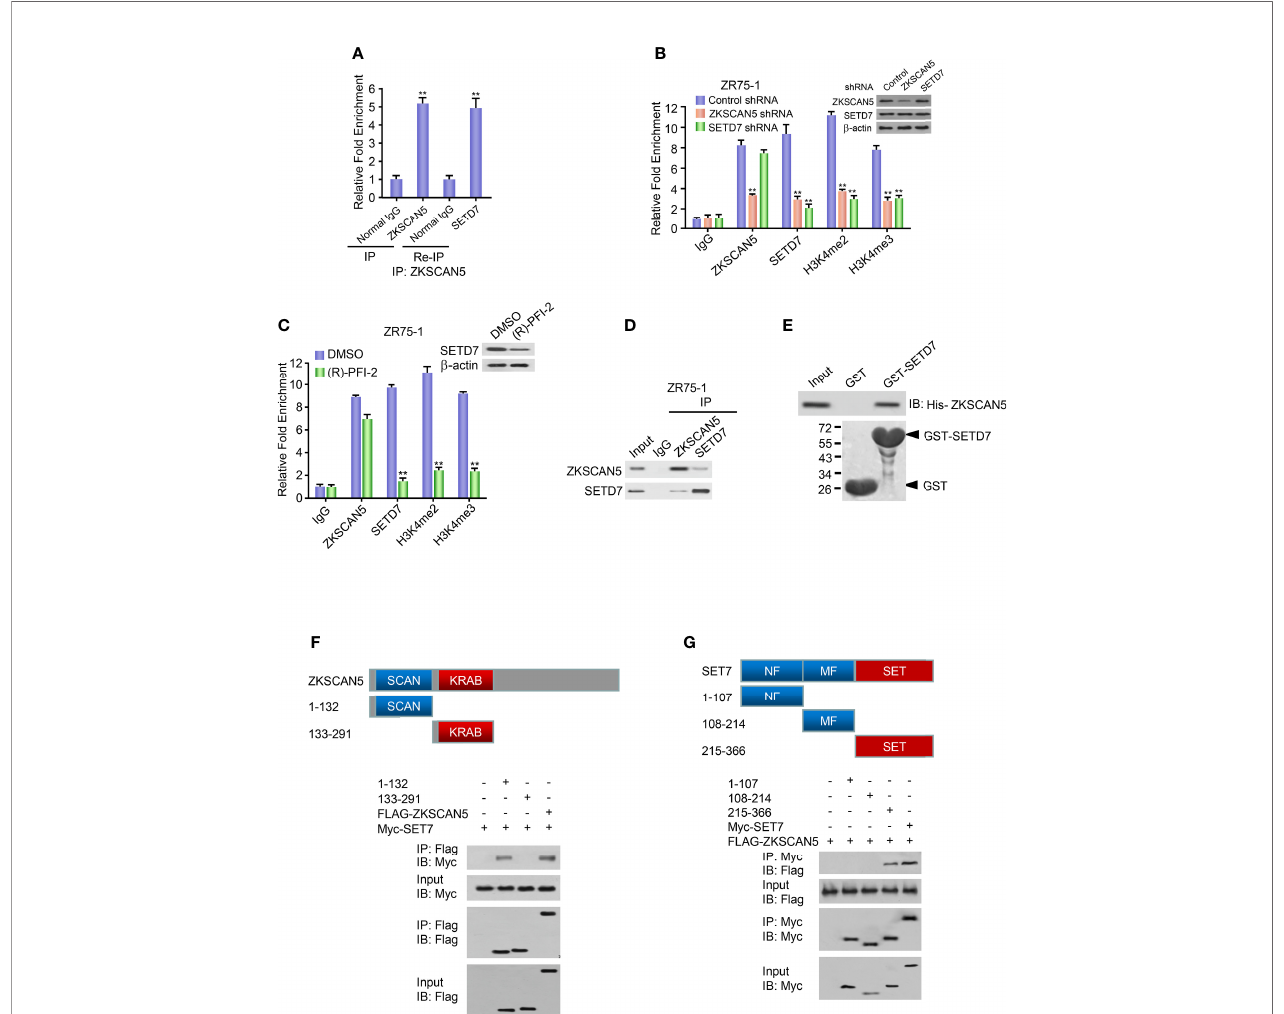
FIGURE 5 | ZKSCAN5 and SETD7 constructed a complex on the − 658- to − 608-bp region of the VEGFC promoter. (A) Re-ChIP analysis of the occupancy of ZKSCAN5 and SETD7 on the VEGFC promoter ( − 658 to − 608 bp) in ZR75-1 cells. (B) ChIP analysis of ZR75-1 cells stably infected with lentivirus carrying ZKSCAN5 shRNA or SETD7 shRNA on VEGFC promoter ( − 658 to − 608 bp) with the indicated antibodies. Western blot revealed the knockdown effects of ZKSCAN5 and SETD7. **p < 0.01 versus corresponding control shRNA. (C) ChIP analysis using the SETD7 antibody in ZR75-1 cells treated with DMSO or (R)-PFI-2 on the VEGFC promoter ( − 658 to − 608 bp). (D) Reciprocal coimmunoprecipitation analysis of endogenous interactions among ZKSCAN5 and SETD7. (E) GST pull-down analysis of direct interactions between ZKSCAN5 and SETD7. Puri fi ed His-tagged ZKSCAN5 and GST-SETD7 or GST was used. (F) Mapping of the interaction region of SET7 in ZKSCAN5. HEK293T cells were co-transfected with MYC-tagged SET7 and FLAG-tagged ZKSCAN5 or its deletion mutants. Anti-FLAG immunoprecipitation was used to precipitate cell lysates, followed by immunoblotting with the speci fi ed antibody. The schematic diagram shows ZKSCAN5 and its deletion mutants. (G) The mapping highlights the interaction region of ZKSCAN5 in SET7. HEK293T cells were co-transfected with MYC-tagged ZKSCAN5 and FLAG-tagged SET7 or its deletion mutants. Immunoprecipitation of the cell lysate was analysed in (A) . The schematic diagram shows SET7 and its deletion mutants; MF, middle region fragment; SET, SET domain- containing fragment. All values shown are the mean ± SD of triplicate measurements from experiments that have been repeated three times with similar